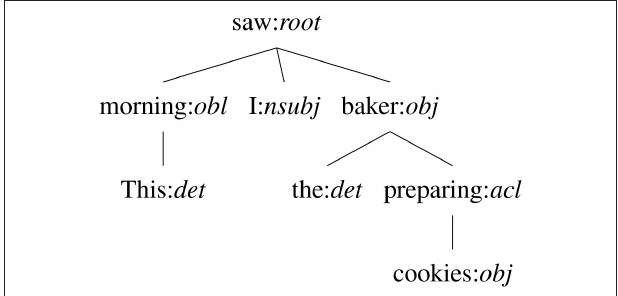
FIGURE 1 | Example dependency tree of the sentence “This morning I saw the baker preparing